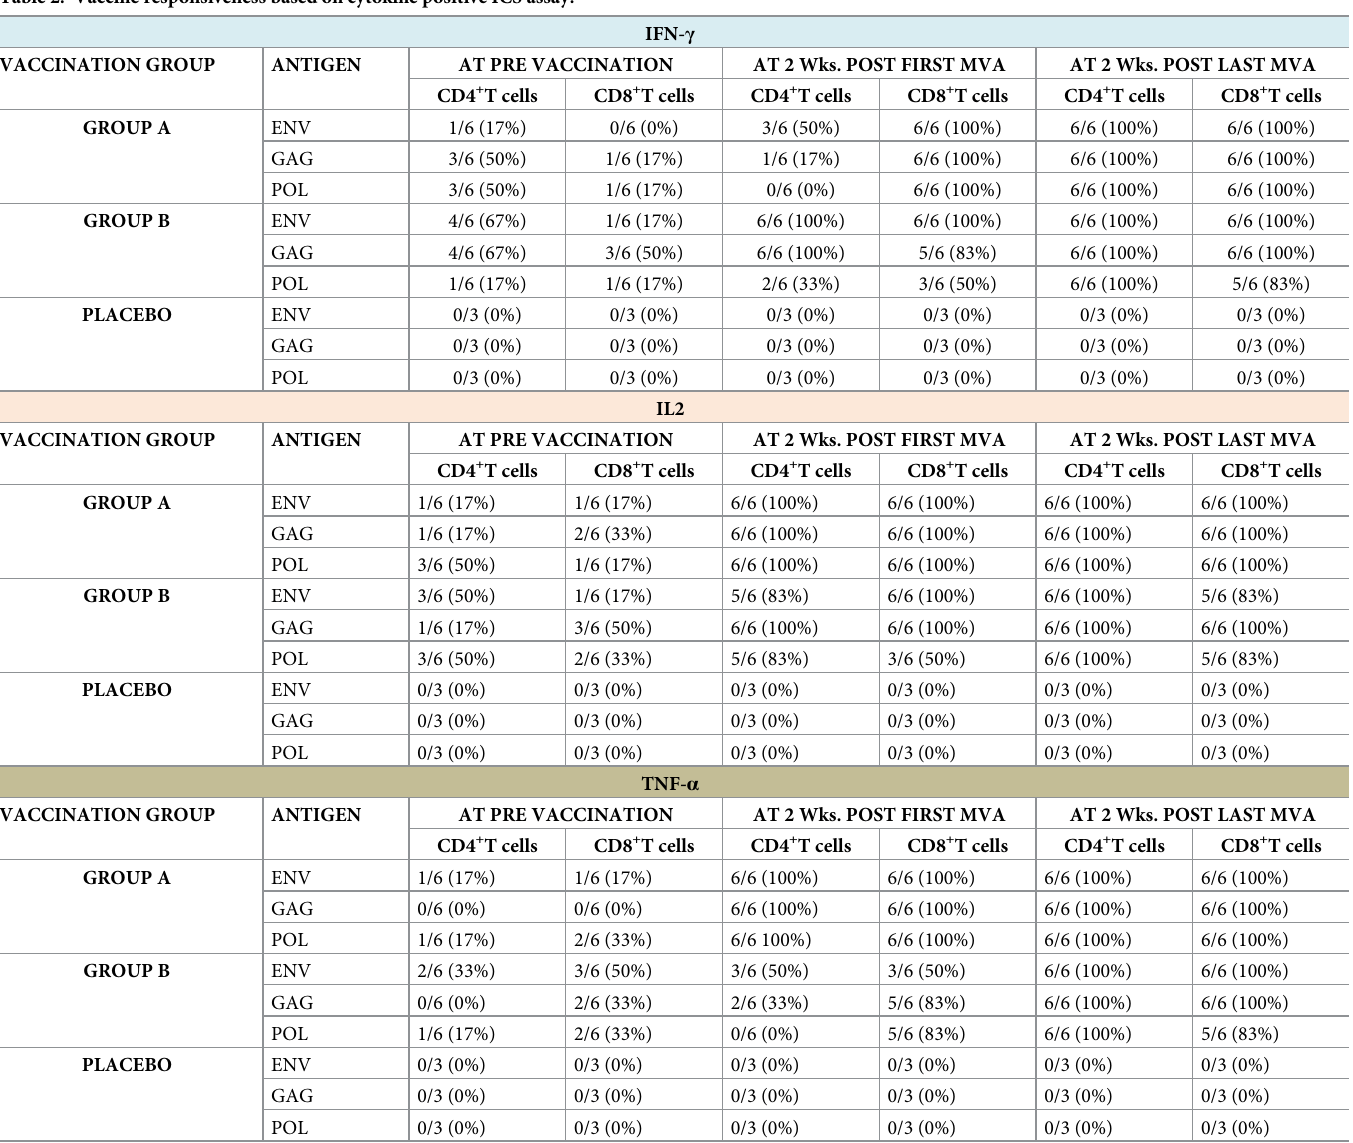
Table 2. Vaccine responsiveness based on cytokine positive ICS